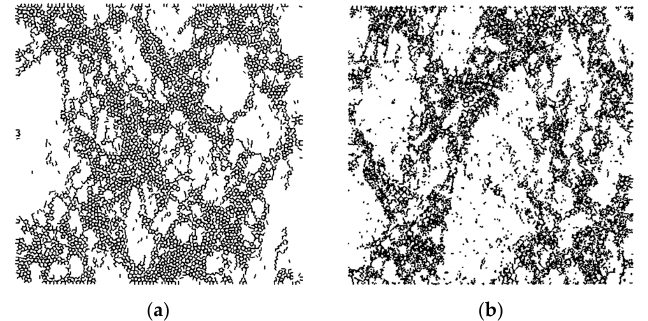
Figure 9. Simulation compression failure diagram of concrete. ( a ) Ordinary concrete. ( b ) Nano-TiO 2 modified concrete.